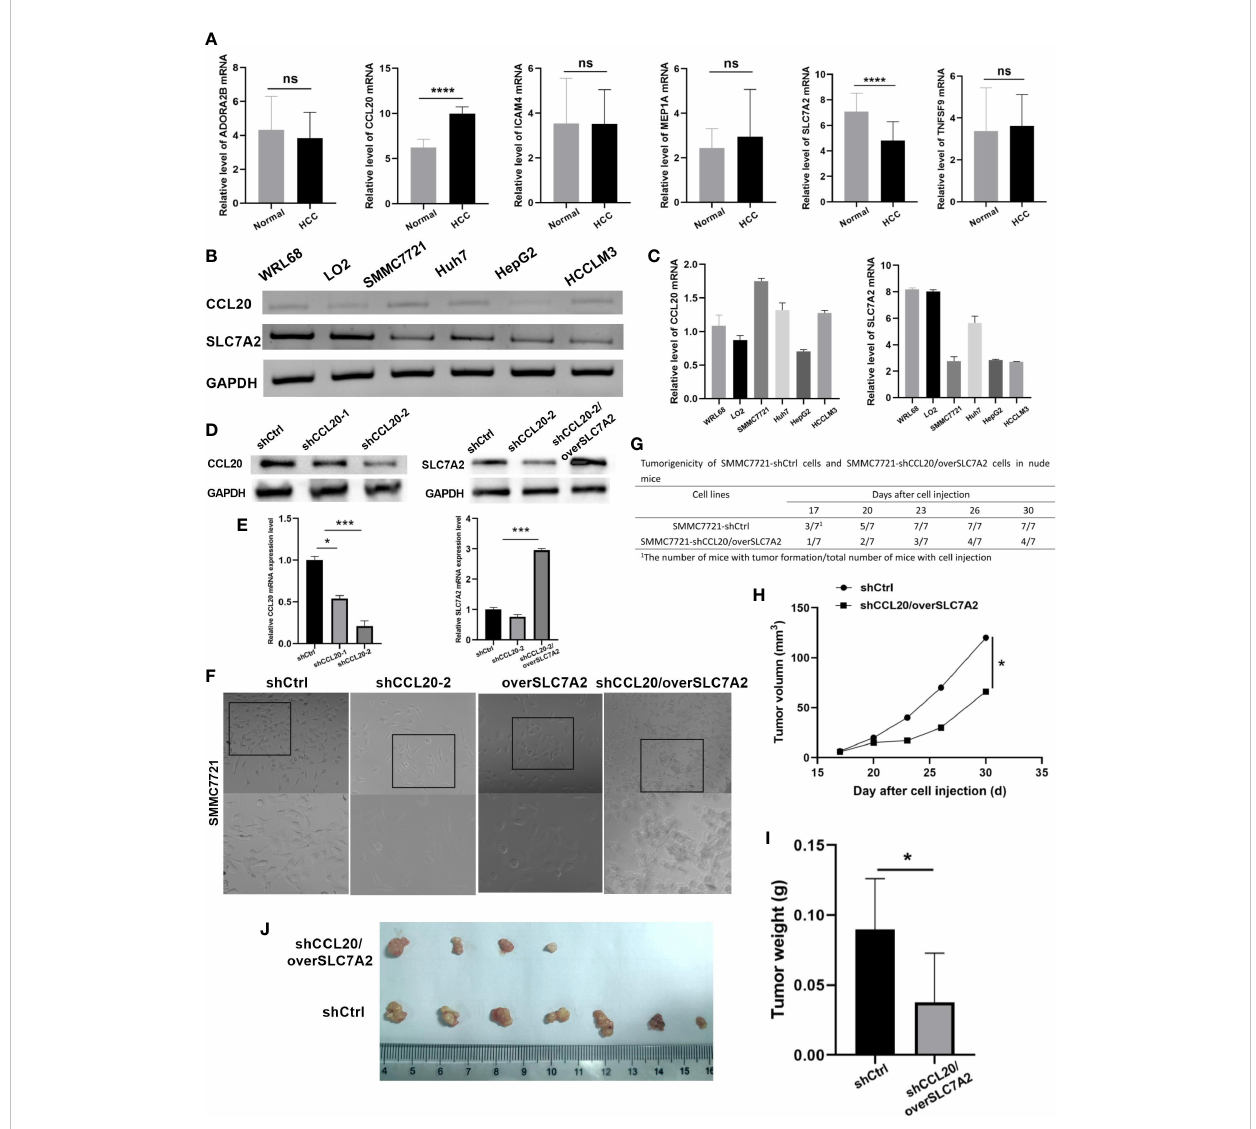
FIGURE 10 Validation of expression and tumorigenicity of hub genes. (A) qRT-PCR validation of MEP1A, CCL20, ADORA2B, TNFSF9, ICAM4, and SLC7A2 in HCC and normal plasmas. (B, C) The mRNA expression level of CCL20 and SLC7A2 in HCC cell lines (SMMC7721, Huh7, HepG2, and HCCLM3) and the normal liver cell lines (WLR68, and LO2) was indicated by qRT-PCR assays. (D) The protein and (E) mRNA expression of CCL20 and SLC7A2 was analyzed by western blotting and RT-PCR in stable SMMC-7721 cells expressing-shRNA against luciferase or CCL20 and over SLC7A2. (F) Morphology of HCC cells after knockdown of CCL20 and overexpression of SLC7A2. (G) Tumorigenicity of SMMC7721-shCtrl cells and SMMC7721- shCCL20/overSLC7A2 cells in nude mice. (H) Tumor volume was measured every 3 days after tumor formation in nude mice injected with SMMC7721 cells transfected with shCtrl or shCCL20/overSLC7A2. (I, J) Tumor weight was measured in nude mice injected with SMMC7721 cells transfected with shCtrl or shCCL20/overSLC7A2 after 30 days. *p < 0.05; **p < 0.01; ***p < 0.005; ****p < 0.0001, ns, not signi fi